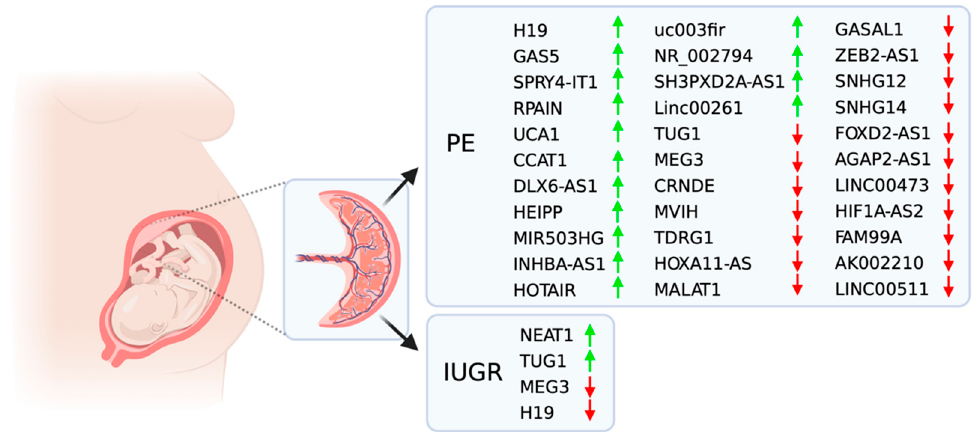
Figure 1. Overview of lncRNA associated with Preeclampsia (PE) and Intrauterine Growth Restriction (IUGR). The green and red arrows indicate upregulated or downregulated lncRNAs, respectively, in these pregnancy pathologies. Created with BioRender.com.